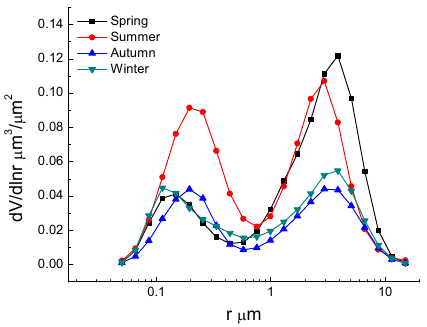
Figure 3. Particle size distribution for different seasons of Beijing station in 2015.